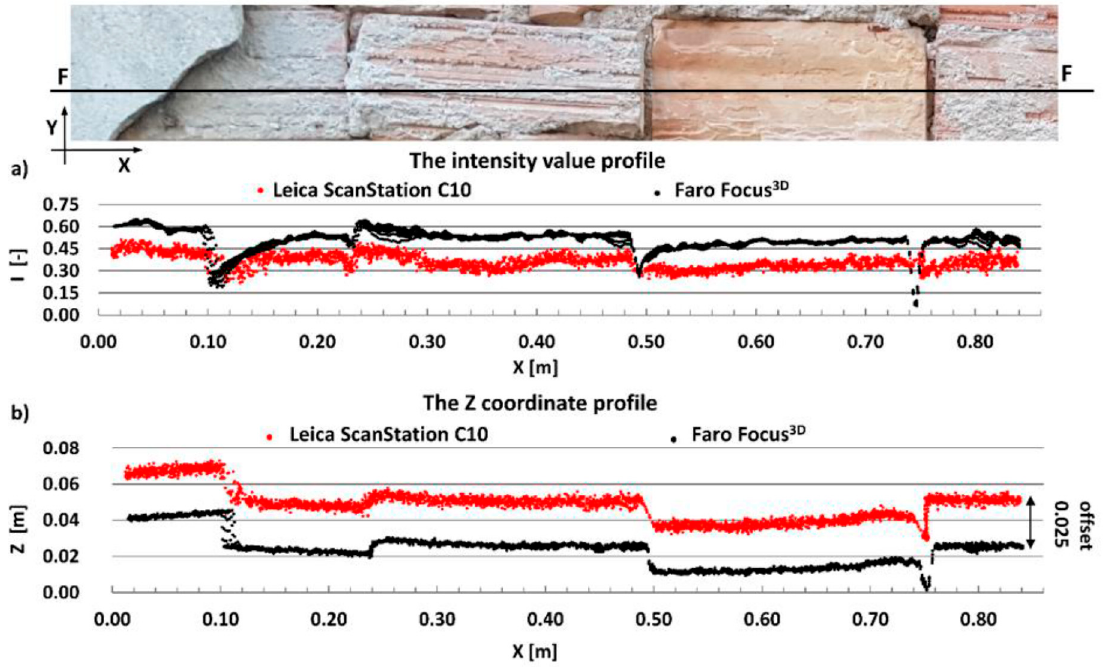
Figure 8. EE profiles—brick wall with damaged plaster, ( a ) intensity data profile, and ( b ) geometric data profile.